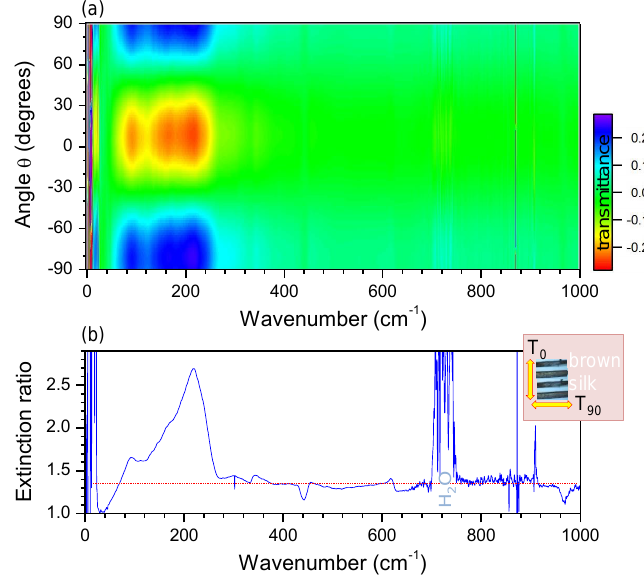
Figure A2. Far-IR measurements of brown silk grating (as shown in the optical image in Figure A1); radiation source was far-IR synchortron beamline. ( a ) The orientational transmittance spectrum map at different polarisation angles θ . ( b ) Extinction ratio (the maximum-to-minimum transmission ratio) for the brown silk grating. The inset shows orientation conventions for the transmittance and extinction ratio σ ex = T 0 / T 90 . Note different wavenumber scales for the panels ( a , b ).